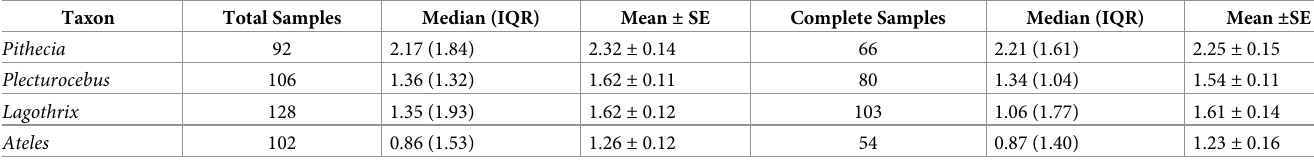
Table 4. Time of first feeding bouts (hours relative to sunrise).